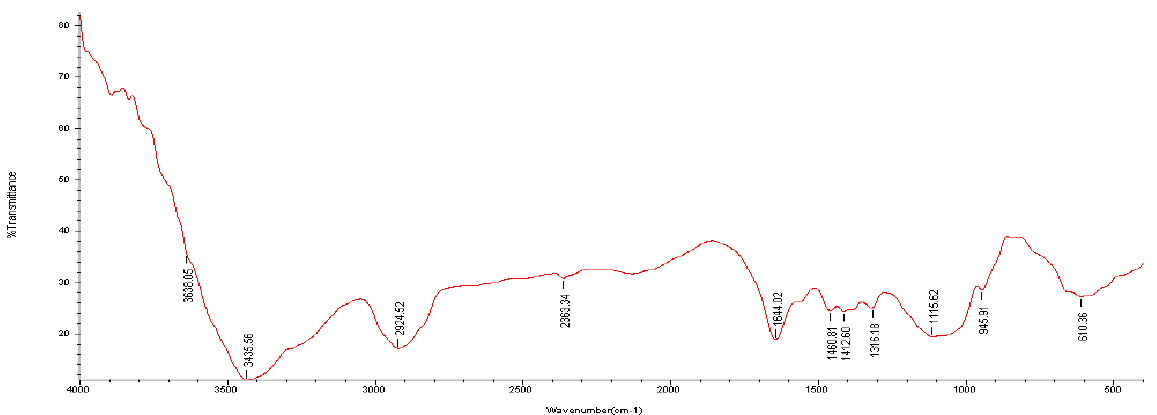
The DSC thermogram of selected formula (F3) of rebamipide ocular insert did not show a noticeable peak; this may be due to the dilution effect of mixing small amount of rebamipide within other excipient.